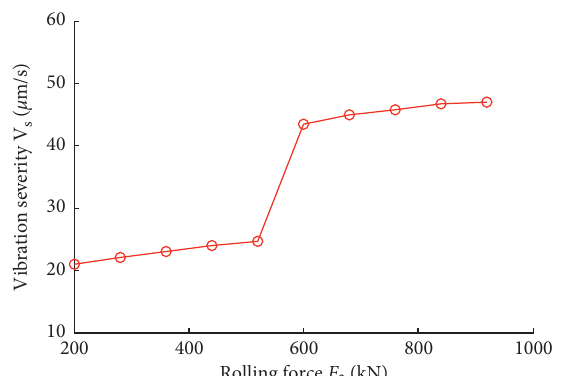
Figure 15: Variation curve of vibration severity under different roll force.